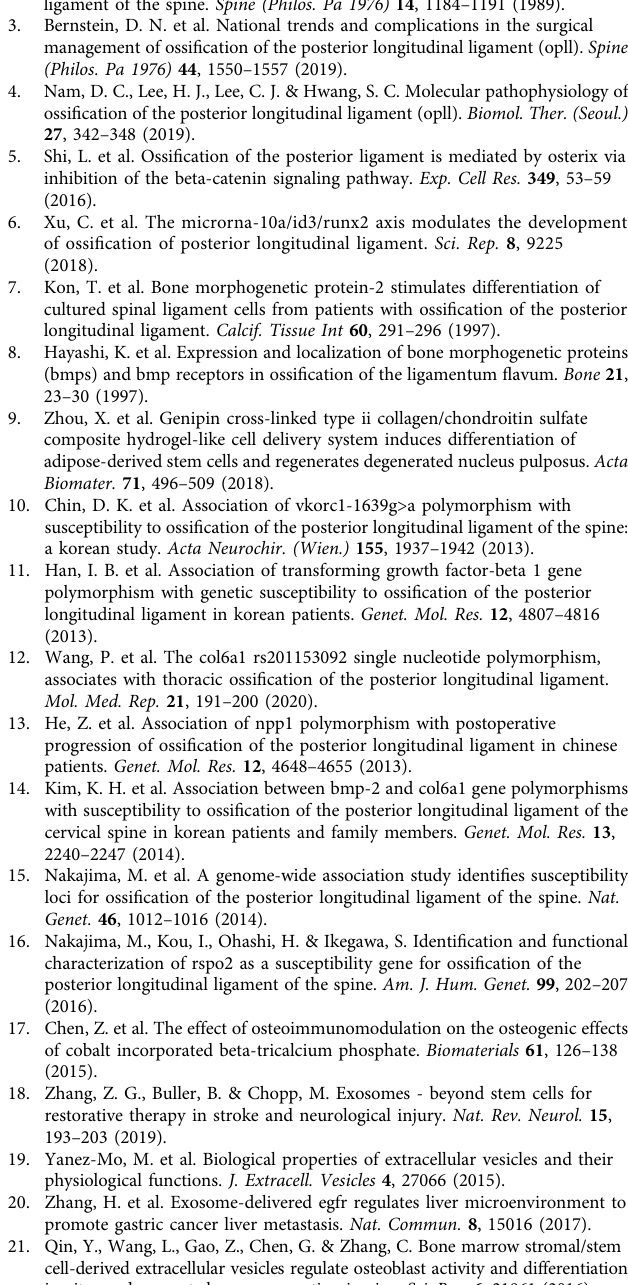
Fig. 10 sEV derived miR-320e promoted OPLL development in ttw mice. A Experimental outline of in vivo OPLL formation assay using ttw mice injected with OPLL-sEVs or miR-320e inhibited sEV. Injections were performed once every 2 days for one week. Mice were sacri fi ced upon death or until 18 weeks after last injection, spine samples were harvested and limb functions were observed everyday. B Immunohistochemistry analysis showing the distribution of human CD81 expression in OPLL-sEV injected spine tissue ( n = 3). Note that in the Blank group, no cellular CD81 expression were found. While in OPLL- sEV injected group, the ligament cells displayed strong expression of human CD81. The scale bars represent 500 μ m. C micro-CT images of spine harvested spines from ttw mice in various groups. The occupation percentage of the ossi fi ed mass in the spinal canal of ttw mice were compared (lower right panel, n = 6, one-way ANOVA). D H&E staining, TRAP staining and immunohistochemistry analysis showing the expression of TAK1 and OCN in the spine samples from treated ttw mice were analyzed ( n = 6). AF stands for annulus fi brosus, NP stands for nucleus pulposus and L stands for posterior longitudinal ligament. The scale bars represent 800 μ m. E The quanti fi cation of TRAP positive, TAK1 positive and OCN positive ligament cells in the posterior longitudinal ligament region were shown and compared, n = 6 for each marker tested, one-way ANOVA. F The conclusive illustrations depict the potential mechanism uncovered in this study. All data were presented as the mean ± SD. * p < 0.05, ** p < 0.01. Detailed statistical data and source data are provided in a Source Data fi